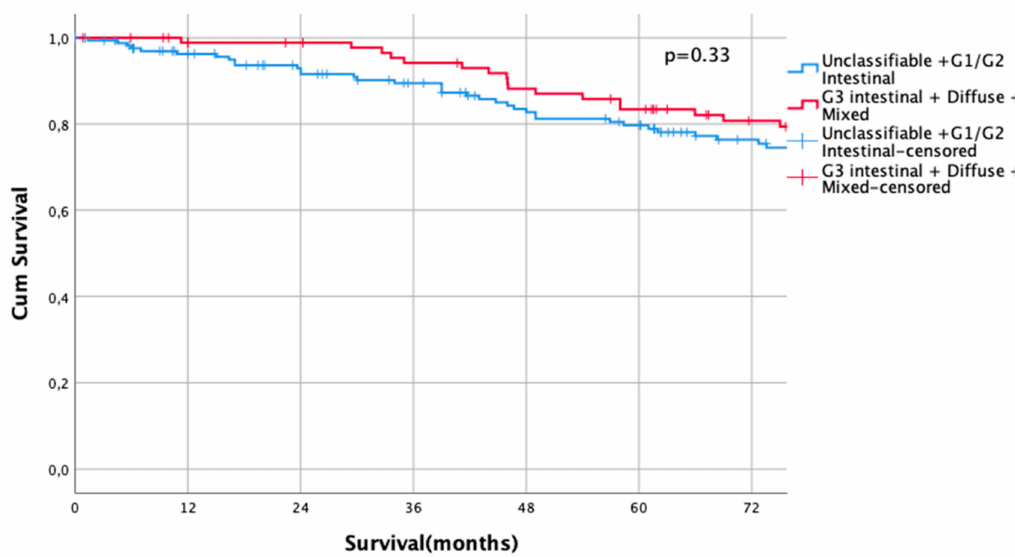
Figure 3. Survival curves for differentiated/undifferentiated subtypes after propensity score matching (PSM) in UICC I stage. Survival UICC I ( n = 260) for a differentiated type (unclassifiable Lauren type, Lauren intestinal type, G1 and G2) vs. undifferentiated type (Lauren intestinal type, diffuse type, and mixed type). HR 0.79, CI95% 0.5–1.27, p =